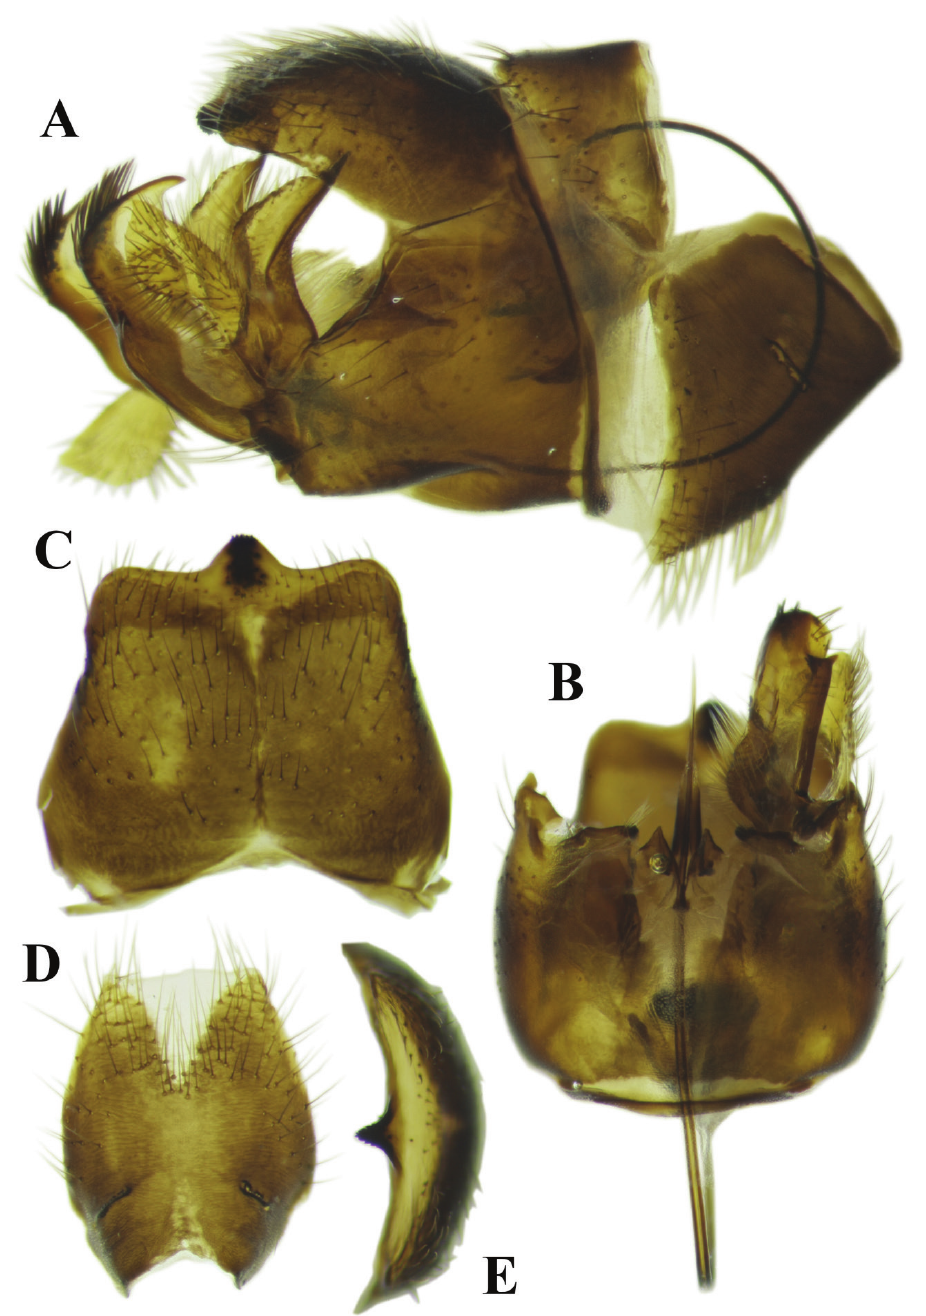
Figure 2. Photographs of the morphological structures of the male terminalia of the Tipula (Mediotipula) gjipeensis sp. n. A lateral view B distal view C tergite IX dorsal view D sternite VIII ventral view E tergite IX–X, distal